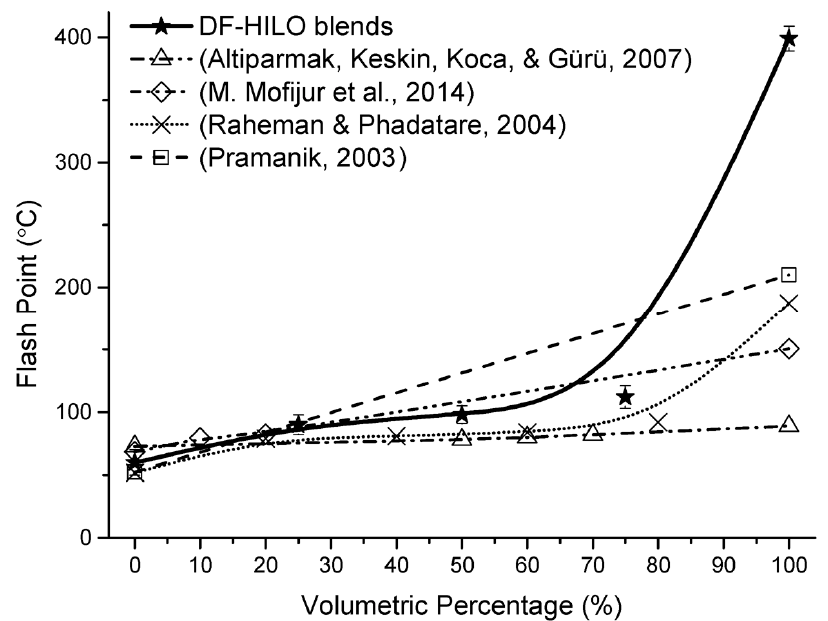
Figure 9. Variation in flash point with volumetric percentage (vol.%) [47,48,50,53].